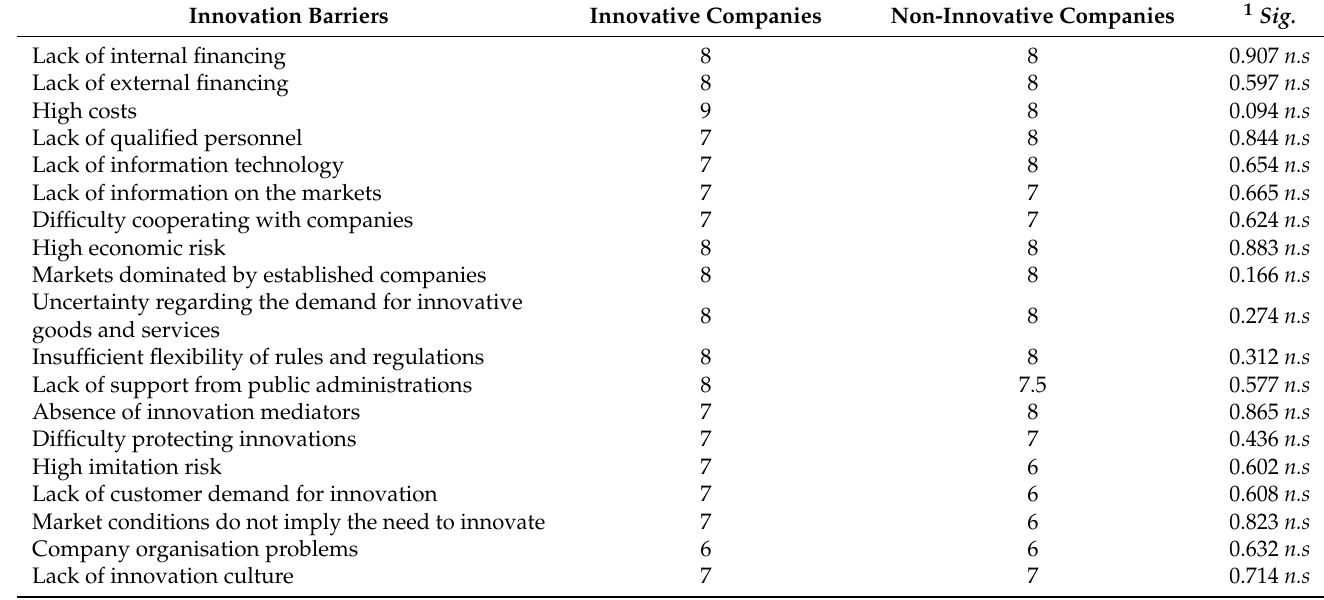
Table 5. Mann–Whitney test: barriers to